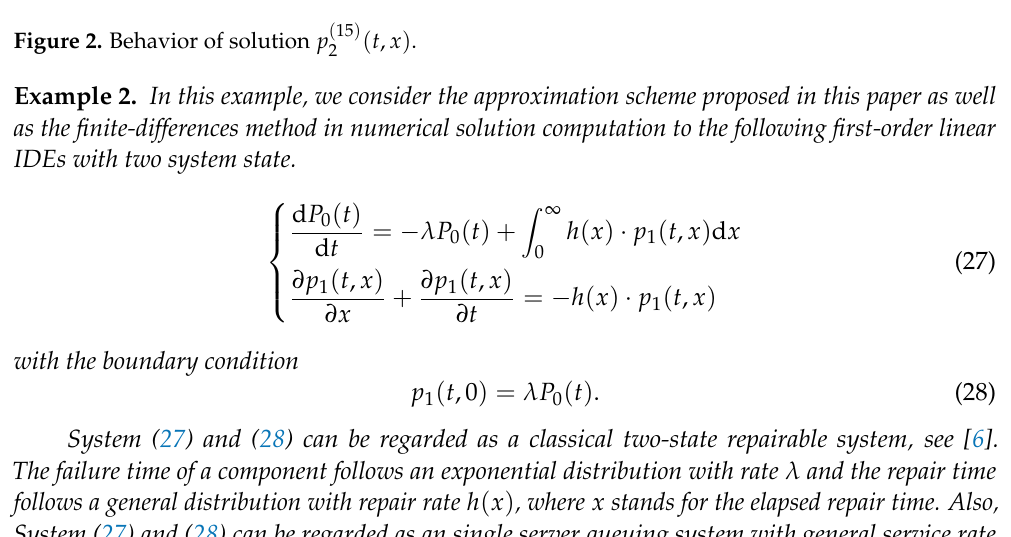
Figure 2. Behavior of solution p